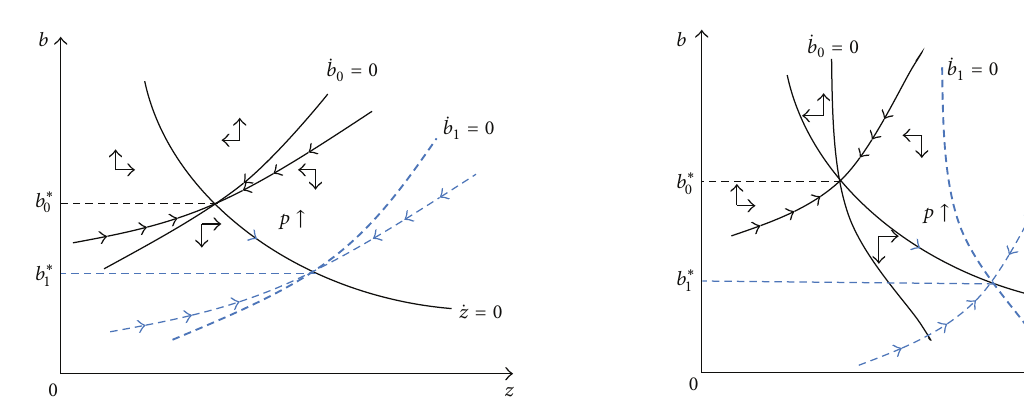
Figure 3: The phase diagram and the effect of a permanent terms- of-trade deterioration for Case 2(a).